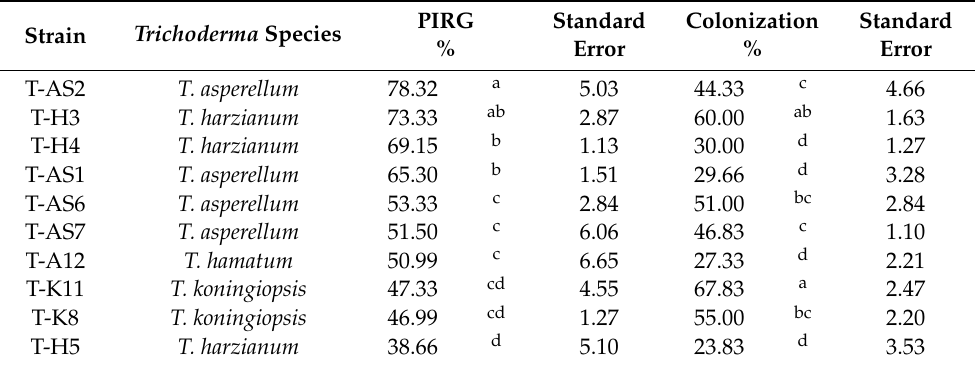
Table 3. Evaluation of the percentage of inhibition and colonization of Trichoderma spp. over Phytophthora cinnamomi .